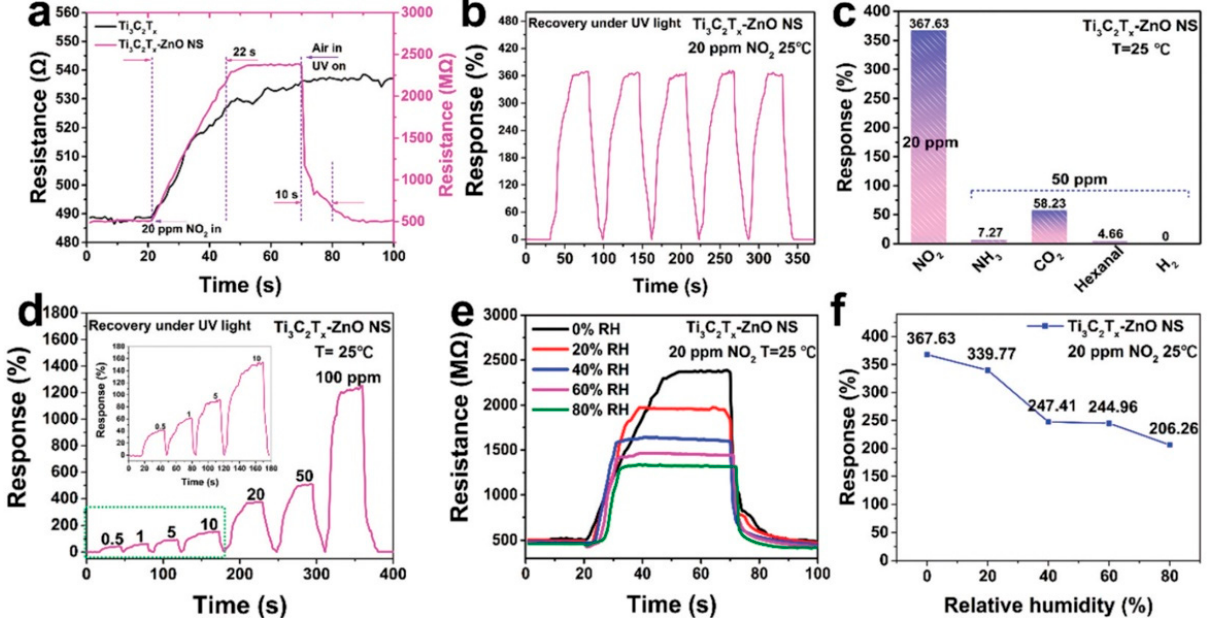
Figure 20. ( a ) Dynamic response and recovery curves under UV irradiation for Ti 3 C 2 T x MXene and Ti 3 C 2 T x –ZnO NS sensors to 20 ppm NO 2 at RT. ( b ) Repeatability tests of Ti 3 C 2 T x –ZnO NS sensor to